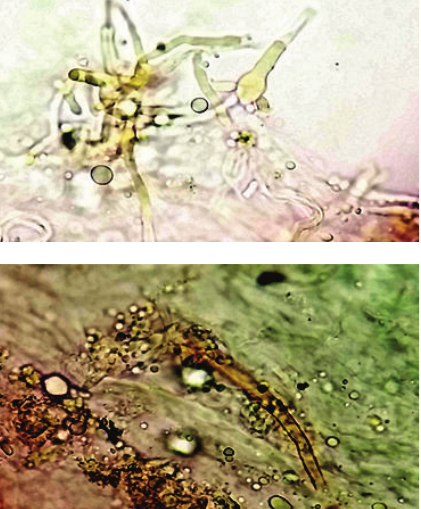
Figure 3: A direct examination of the removed fungus ball showing septate and dichotomous branching hyphae, vesicles, and conidia suggestive of Aspergillus species (KOH + DMSO preparation, ×